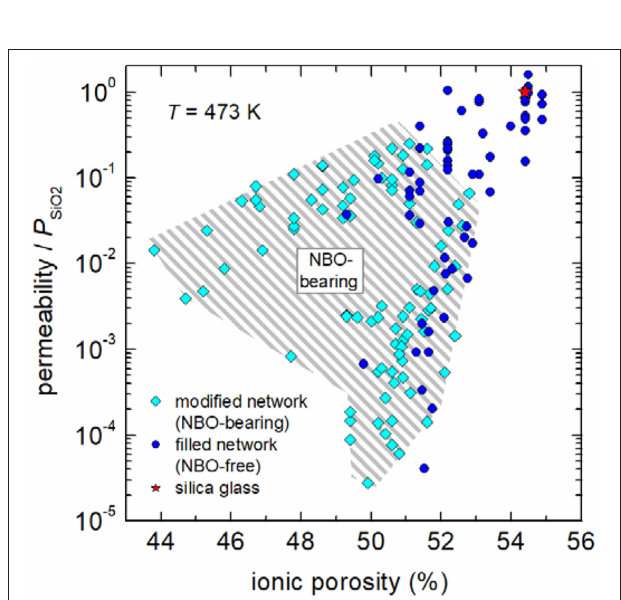
FIGURE 4 | Reduced permeability P / P SiO2 vs. ionic porosity at 473K. Gray hatched area indicate NBO-bearing compositions. Data: see caption of Figure 3 .